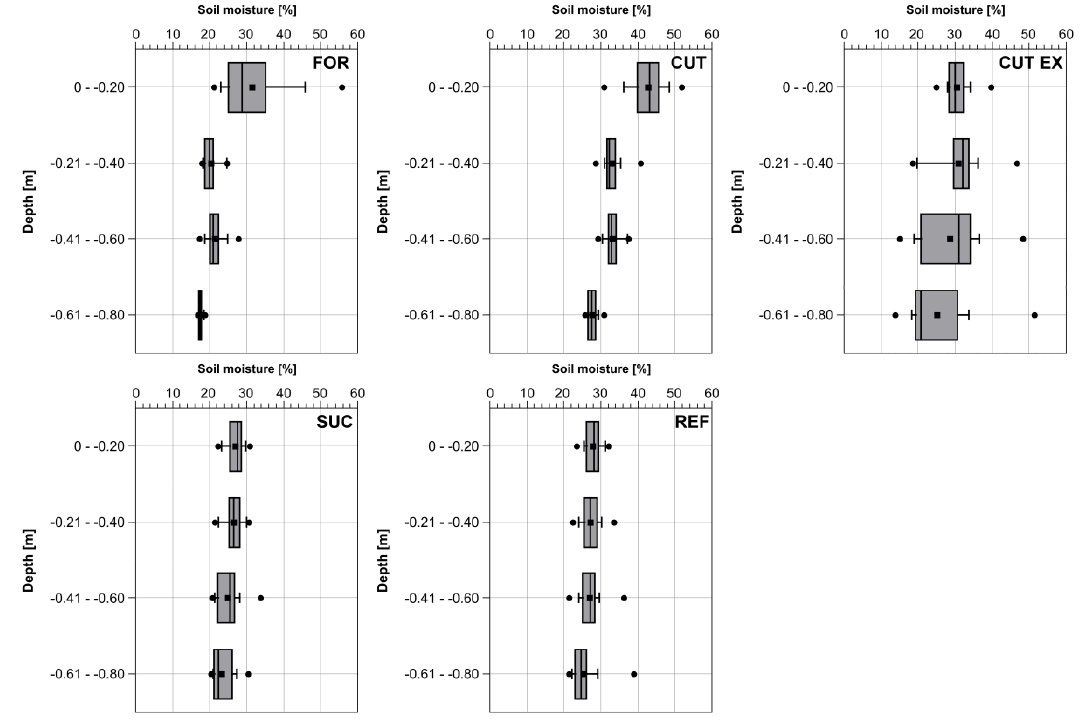
Figure 7. Soil moisture dataset distribution. Recorded in fall 2018 (FOR, CUT, SUC, REF) and early summer 2019 (CUT EX), carried out at the same time as penetrologger measurements. Table 5. Mean soil moisture (SM). Depth aggregated data.